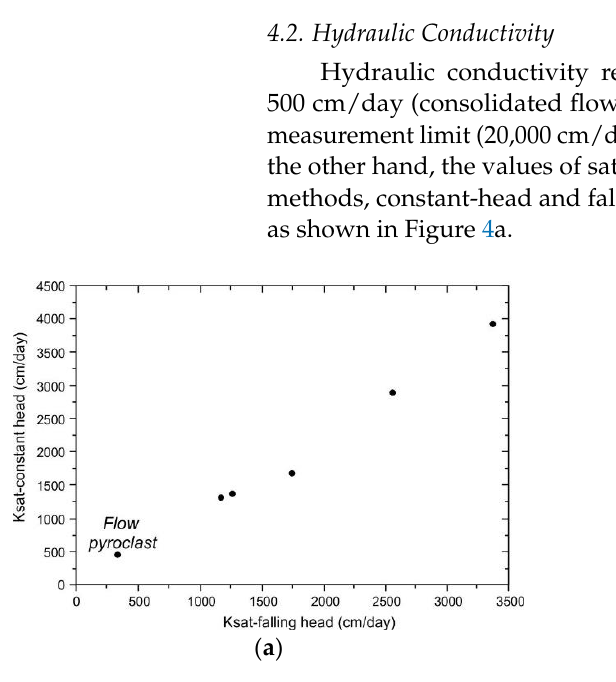
Figure 3. ( a ) ERT cross-section P1. The interpreted pyroclast layer is narrow and the depth of the low-resistivity ignimbritic substrate (<80 ohm-m) appears at about 5 m deep; ( b ) ERT cross-section P3. The inferred pyroclast layer is thicker and the low-resistivity ignimbritic substrate is located more than 15 m deep.